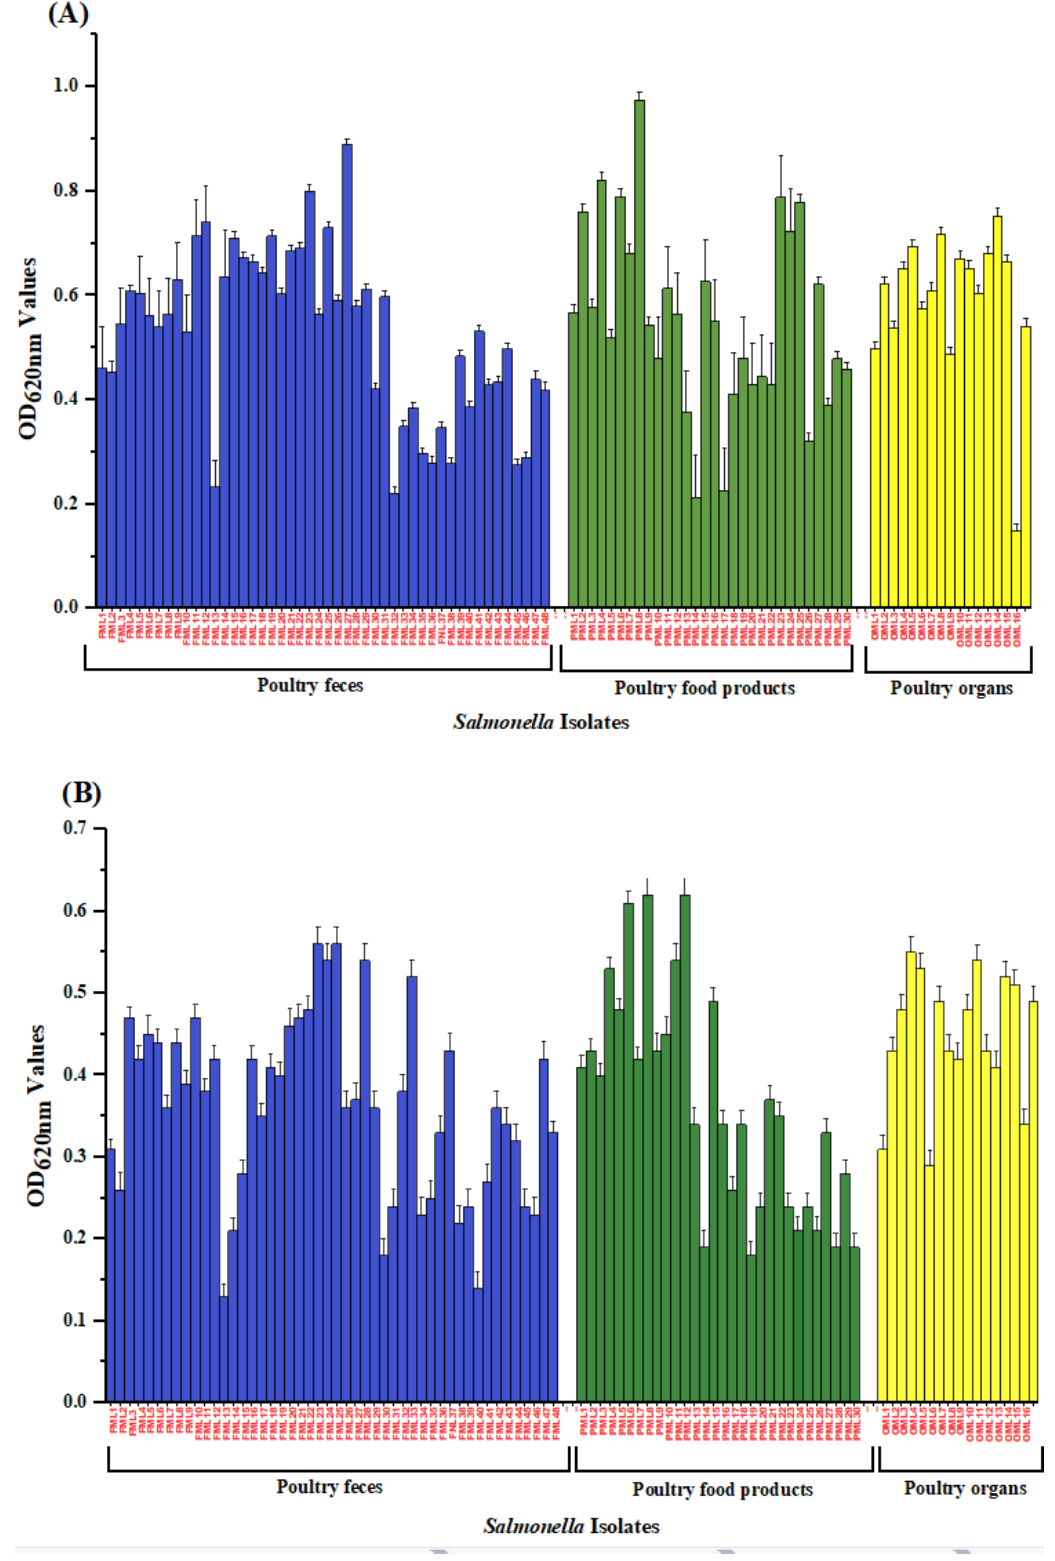
Figure 2. Results of biofilm formation assay. X -axis: Salmonella isolates from poultry droppings; poultry food products; poultry organs at two temperatures, ( A ): 37 °C; ( B ): 30 °C evaluated by crystal violet assay. Biofilm formation was assessed by staining the attached bacteria with 0.2% CV and measuring the OD values at 620 nm after 48 h growth. Error bars represent standard deviations between three replicates.